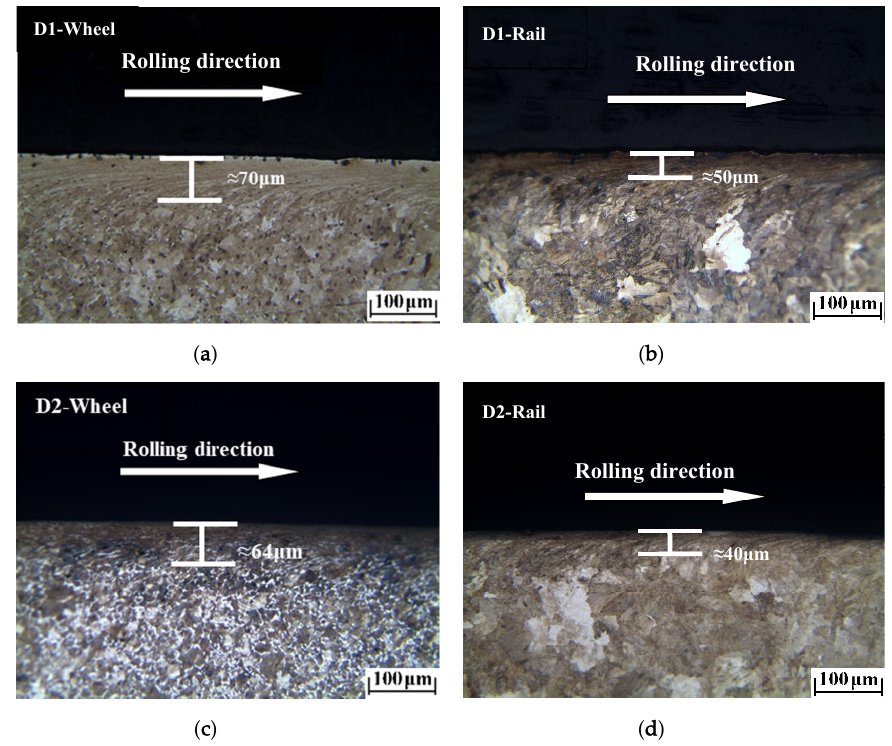
Figure 10. Plastic deformation of wheel and rail rollers at room temperature: (a) D1 wheel; (b) rail of D1 friction pair; (c) D2 wheel; (d) rail of D2 friction pair.